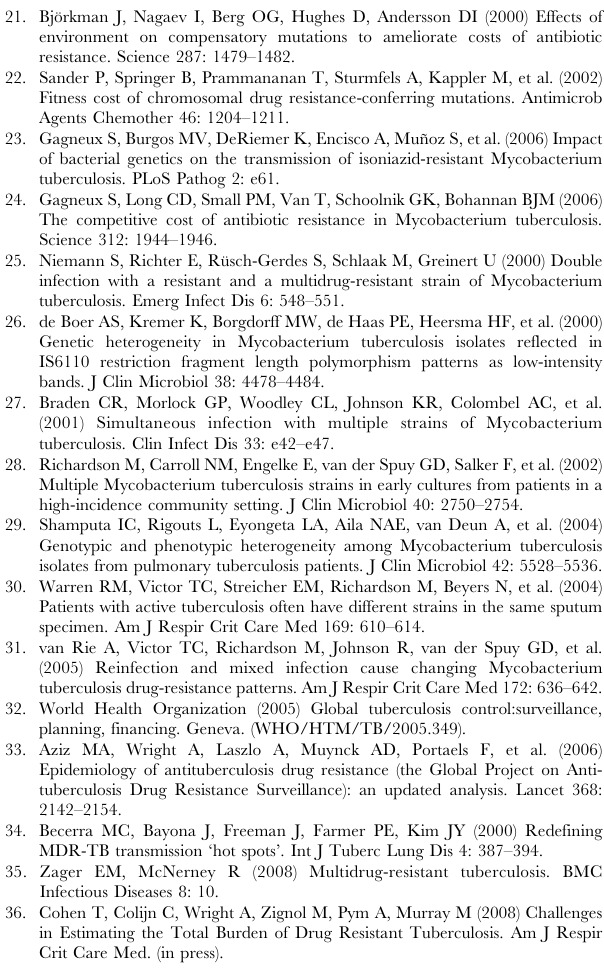
Figure S2 Four hypothetical patient histories demonstrating the time-dependent (relative to infection and re-infection events) rates of progression to active tuberculosis. The height of the bars represents the probability of disease, and the color of the bars correspond to the type of infection (green, drug-sensitive; red,